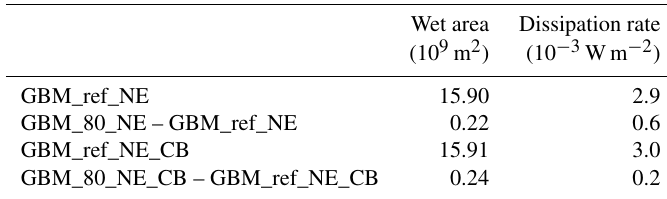
Table 3. Mean flooded area at tidal high water (wet area) in the shallow part of the German Bight out to 20m depth and dissipation rate averaged over that region (see Fig. 2).